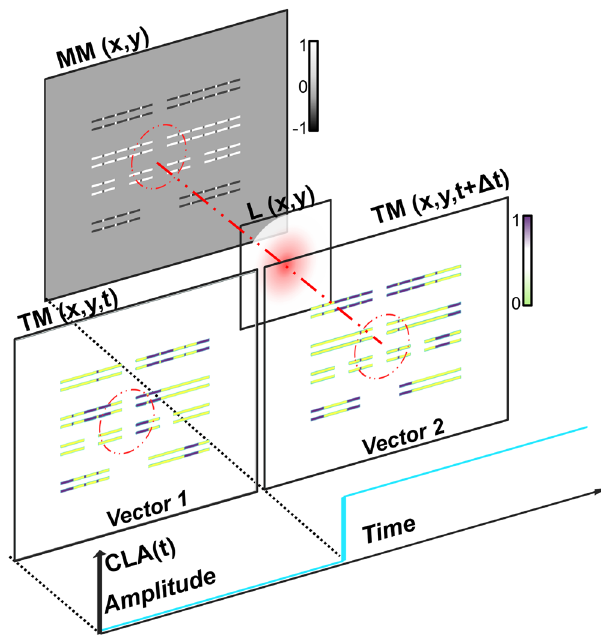
Fig. 5 | Schematic of the MC and CLA simulation. MM contains the relative modulation that the device imparts to the optic probe L. TM changes with each input stimulus, affecting the modulation over time. MC combines MM and TM to contain a time variant map of the relative modulations. A simpleintegration ofthe dot product between MC and L produces the dynamic re fl ected power, which is presented as the simulated waveform